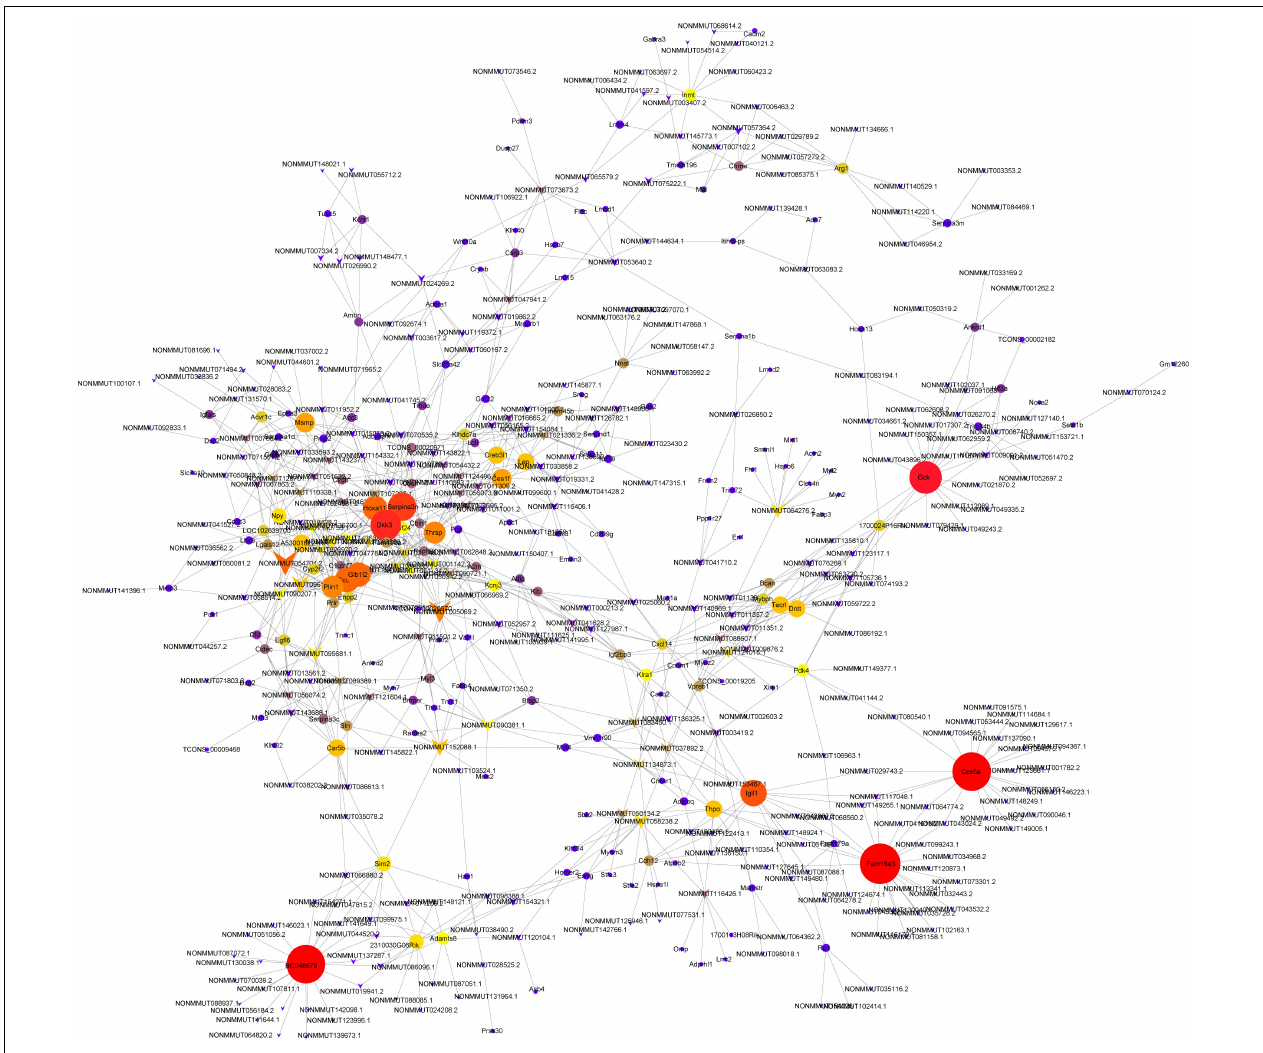
FIGURE 6 | Coexpression networks constructed by weighted correlation network analysis. Circle, mRNA; diamond, long non-coding RNA; line, correlative relationship. Different sizes and colors represent the corresponding k-core